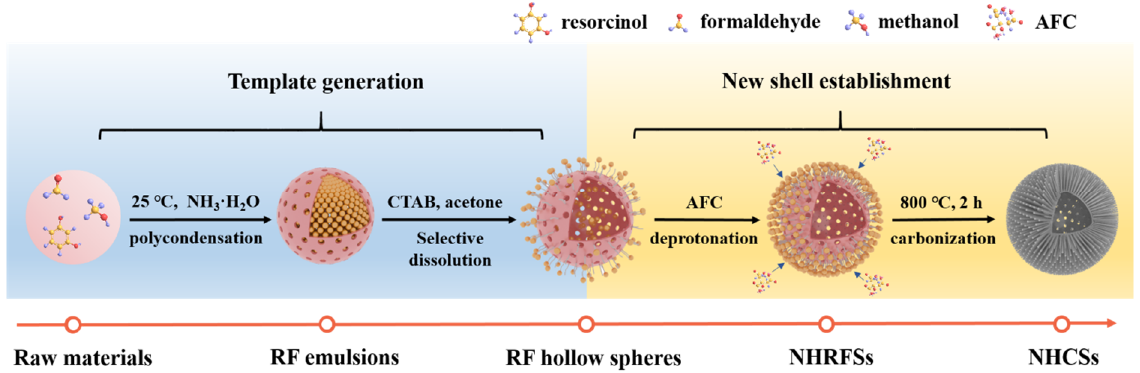
Figure 1. Schematic illustration of the synthetic strategy for NHCS- m .